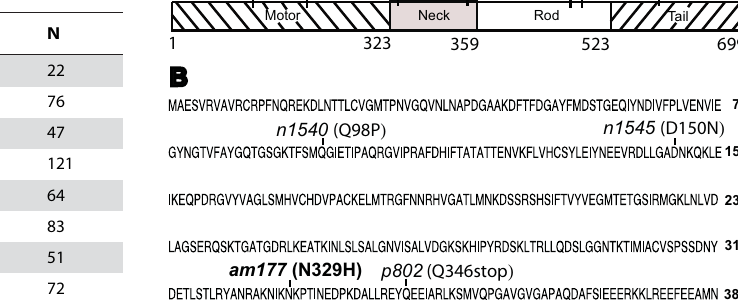
‘ For lines 1–4, hermaphrodites were cultured from conception to L4 at the indicated temperature. For lines 5–8, hermaphrodites were cultured from conception to L4 at 20 u C and then shifted to the indicated temperature for approximately 24 hours.